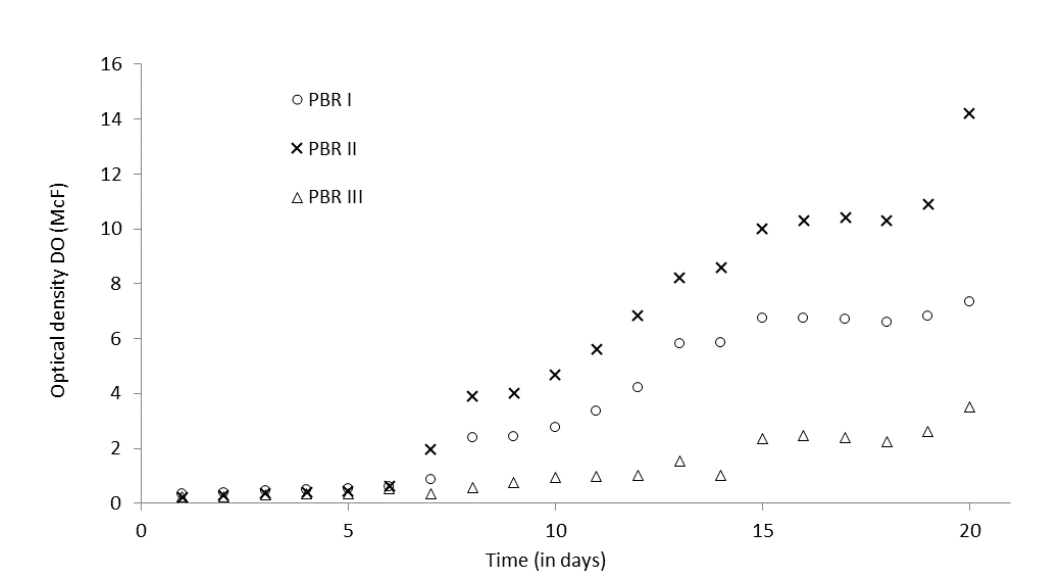
Figure 6. Changes in the optical density of Chlorella vulgaris cultures conducted in photobioreactors with various lighting systems. Source: own study.